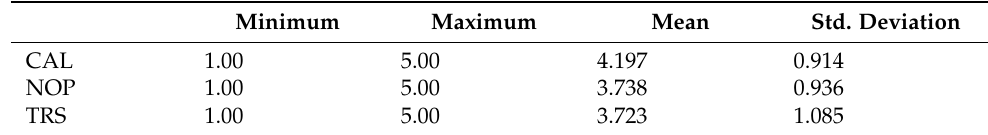
Table 5. Descriptive statistics ( n =